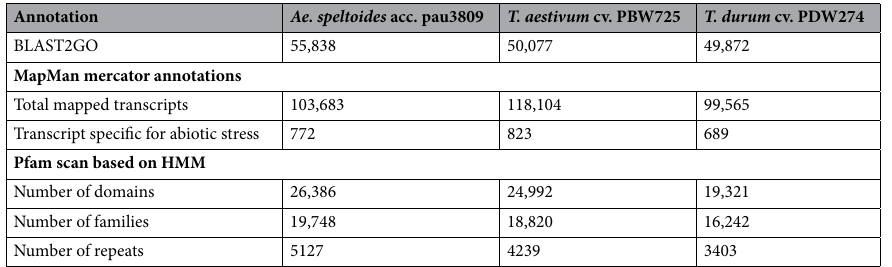
Table 3. Summary of transcripts with significant BLAST2GO alignments and annotation using annotation tools of MapMan Mercator and PfamScan.